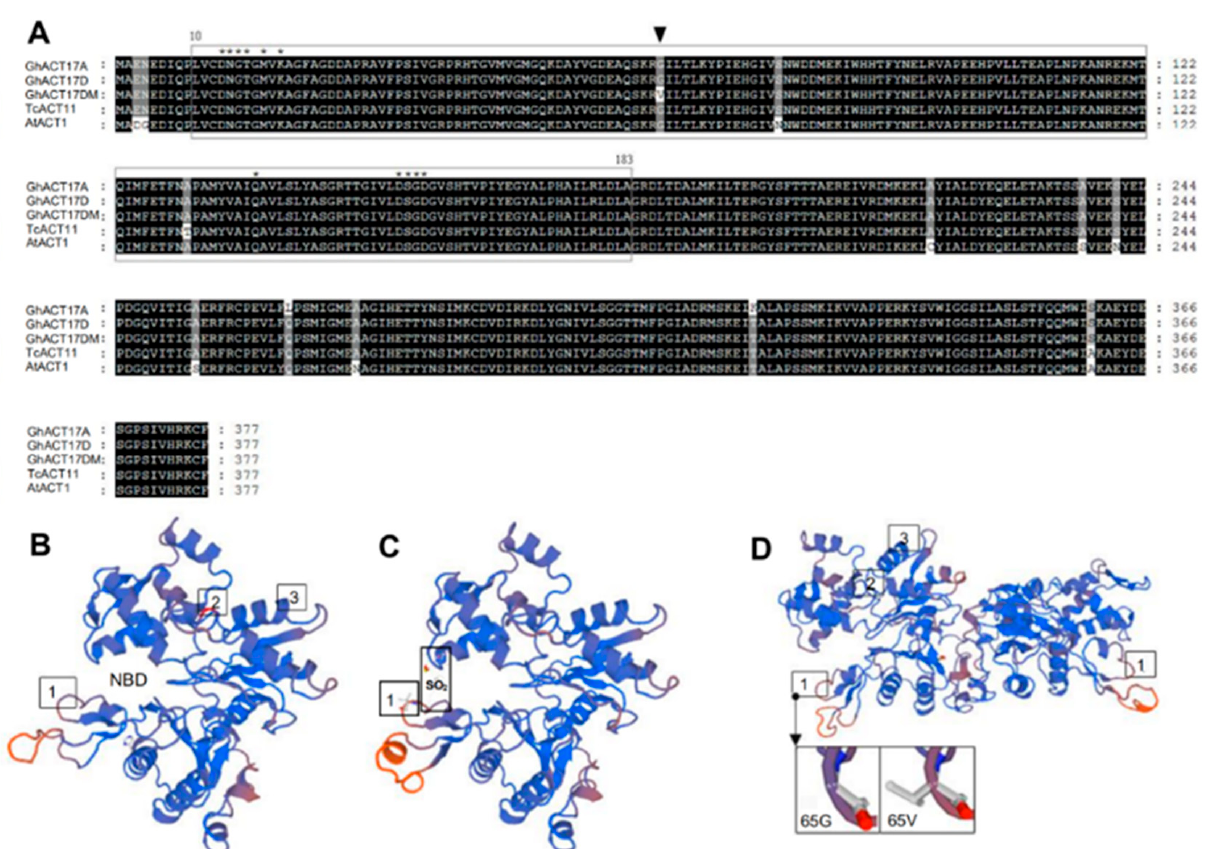
Figure 2. The multiple alignment and protein structure homology model of GhACT17D/GhACT17DM. ( A ), The multiple alignment of GhACT17D/DM homologs and the other actin proteins. The residents labeled by asterisks (*) show the conserved features of the sugar kinase/HSP70/actin superfamily nucleotide binding domain (NBD) model. The NBD in GhACT17D/DM is boxed in (amino acids 10–183). Val, the point of mutation in GhACT17DM, is labeled by a black triangle. GhACT17A is a homolog of GhACT17D listed in Table S5. TcACT11 and AtACT1 are actin genes from other plant (Table S5). ( B ), GhACT17D monomer model using 3ci5.1.A as the template. ( C ), GhACT17DM monomer model using 1nmd.1.A as the template. The V65 in GhACT17DM emerged as a derivative of three branches. ( D ), GhACT17D/DM homo-dimer model using 2oan.1.A as the template. The arrow refers to the enlarged view of the difference between G65 in GhACT17D and V65 in GhACT17DM. 1, 65th amino acid; 2, 265th amino acid; 3, 320th amino acid.